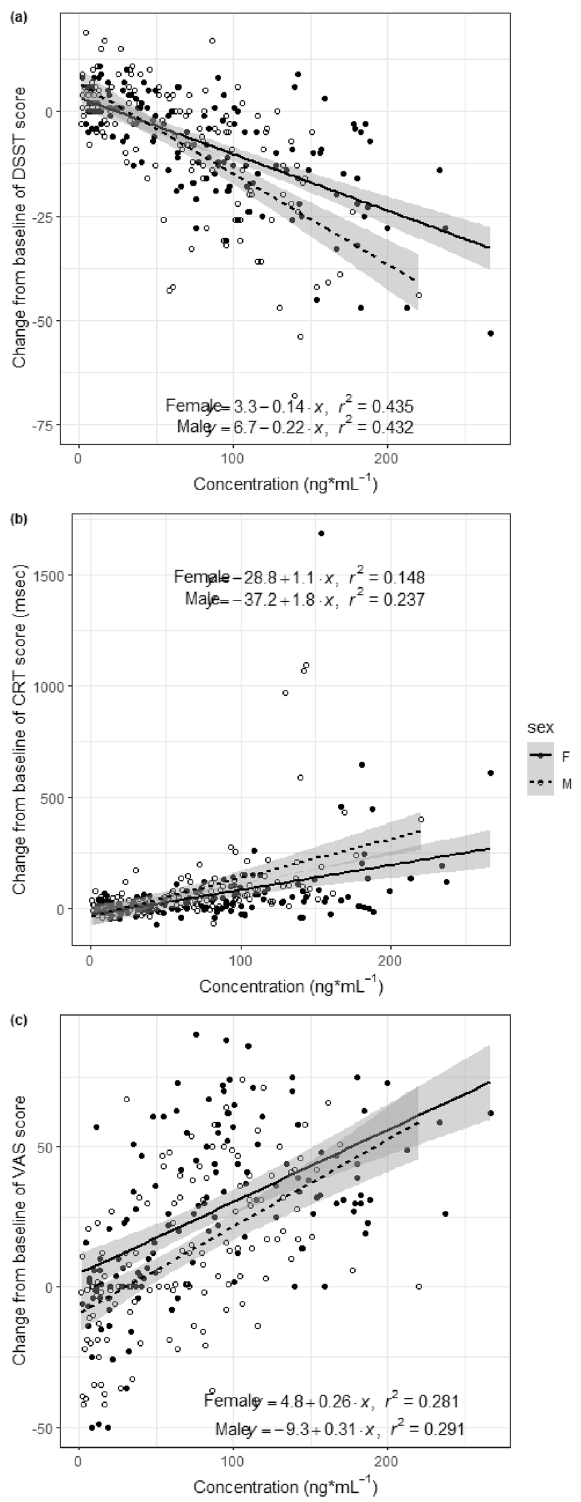
Figure 3. Pharmacokinetics–pharmacodynamics relationship of zolpidem. The relationship between zolpidem concentration and ( a ) digit symbol substitution test (DSST) score changes, ( b ) choice reaction time (CRT) changes, and ( c ) self-rating visual analog scale (VAS) of sleepiness changes. The y-axis represents changes in each pharmacodynamic